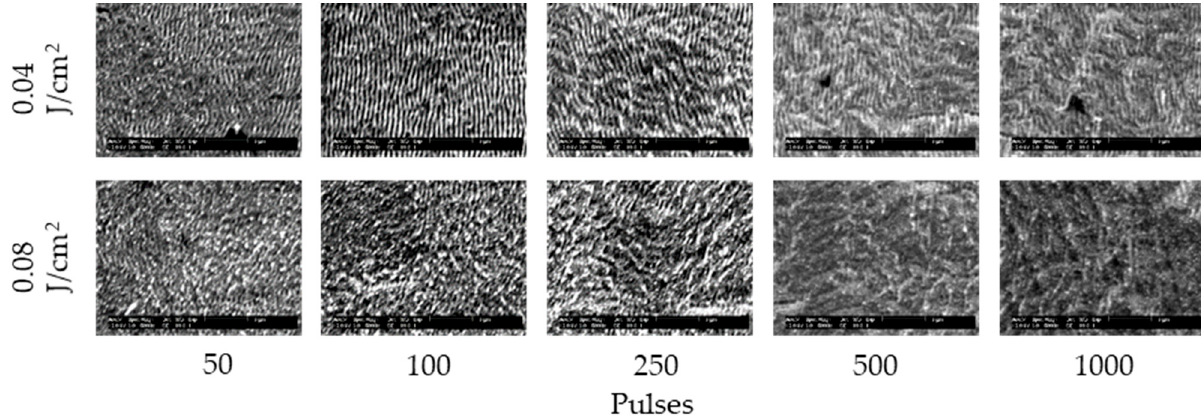
Figure 3. SEM images of 304 stainless steel irradiated with N = 50–1000 pulses at F = 0.04–0.08 J/cm 2 in water. The laser beam has the polarization in a lateral direction.